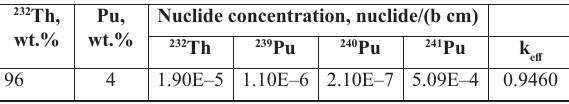
Figure 4. Dependence of the effective multiplication factor of the facility on the mass content of plutonium Pu (a) in the Th Pu composition. a Table 2. Steady-state neutronic characteristics of the simulated system